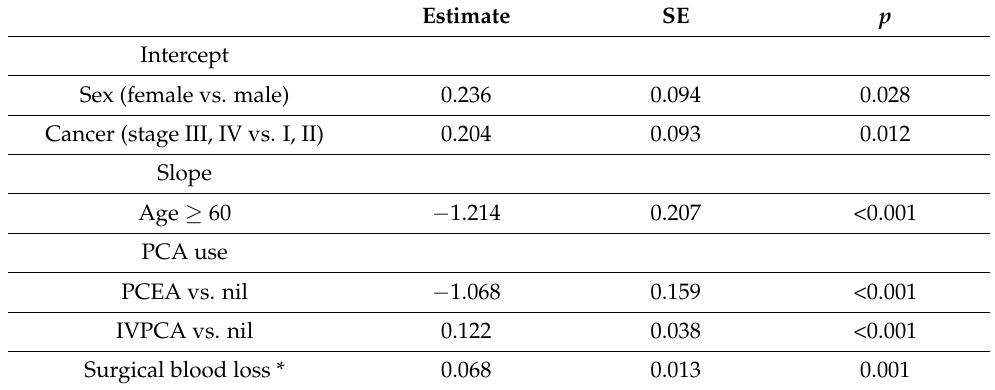
Table 3. The multiple predictor latent curve model after backward model selection.